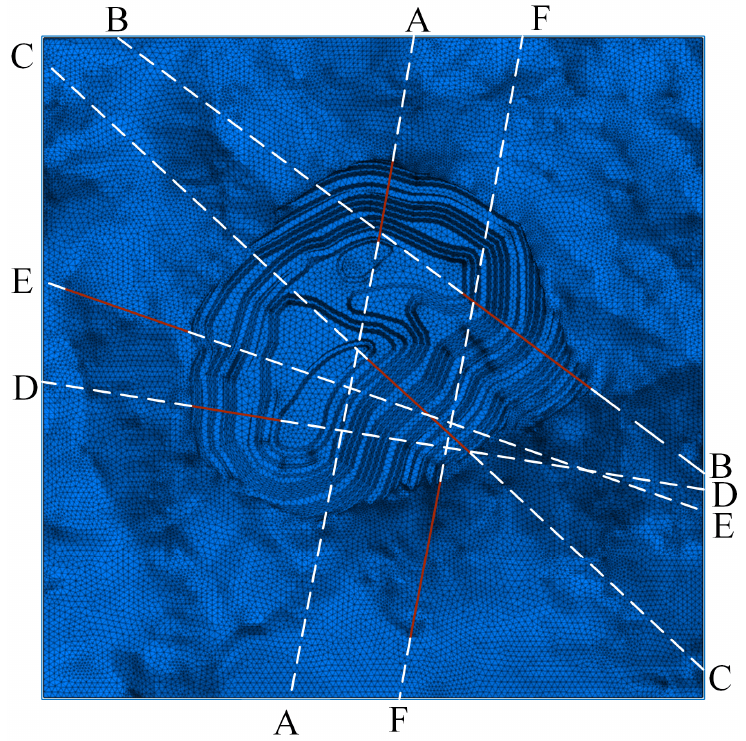
Figure 6. Top view of the established 3D model.